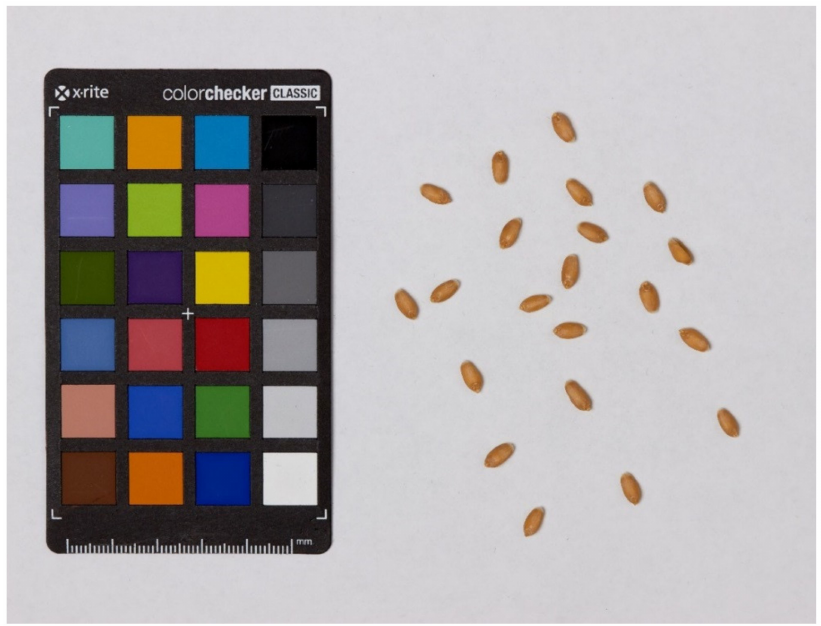
Figure 6. Image of grains of the ITMI_110